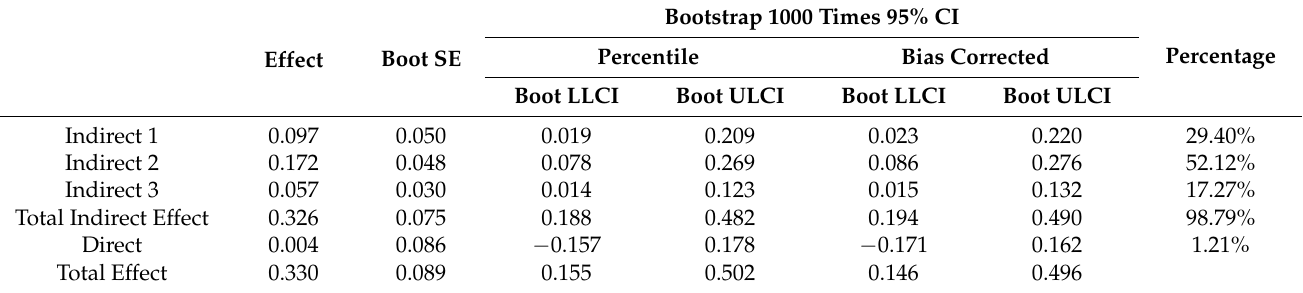
Table 4. Bootstrap analysis of the significance test of the intermediary effect of the chain intermediary